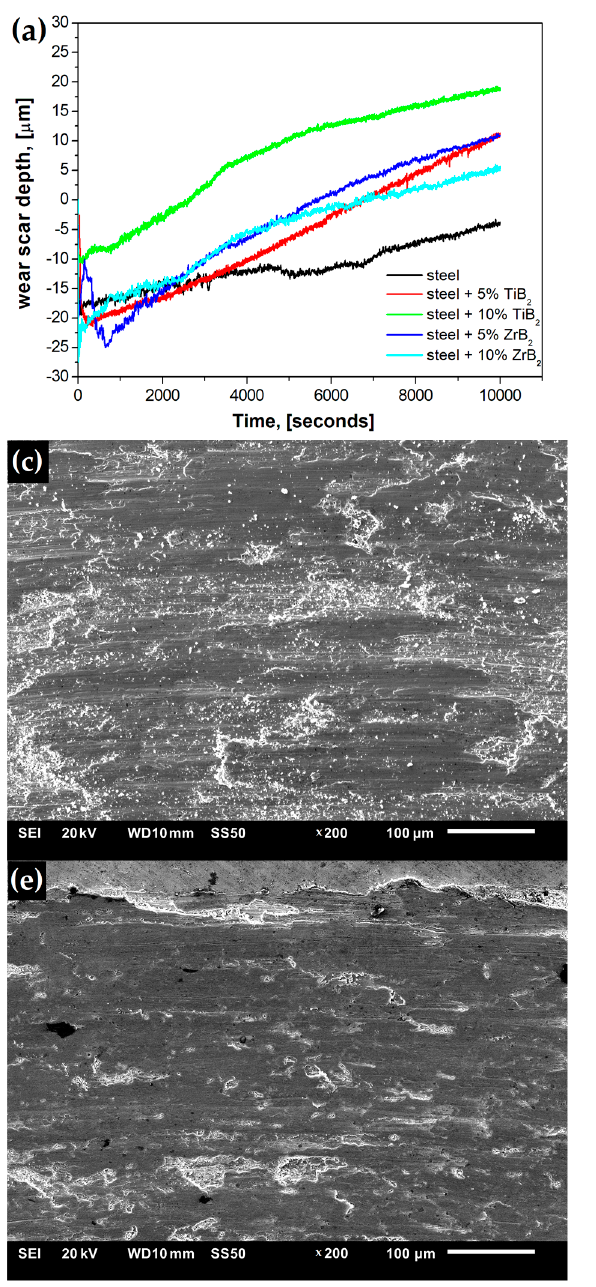
Figure 12. ( a ) Depth of scar as a function of the test duration and SEM micrograph of the worn surface of: ( b ) steel and composites with ( c ) 5% ZrB 2 , ( d ) 10% ZrB 2 , ( e ) 5% TiB 2 , and ( f ) 10% TiB 2 .